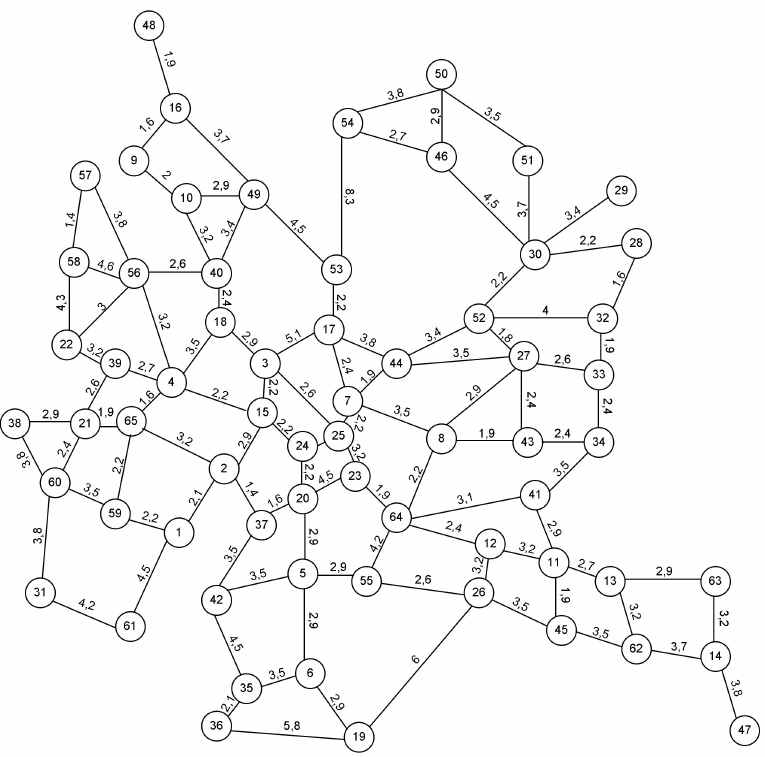
Figure 4. The scheme of zones of Kharkiv city with distances between zones: —attraction of zones (nodes); —links between zones, km.